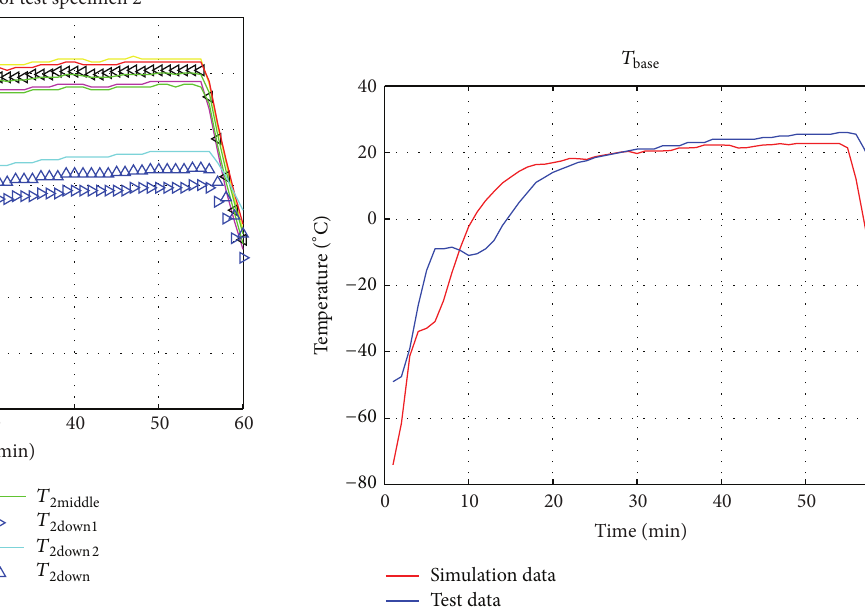
Figure 11: Test temperature data of test specimen 2.